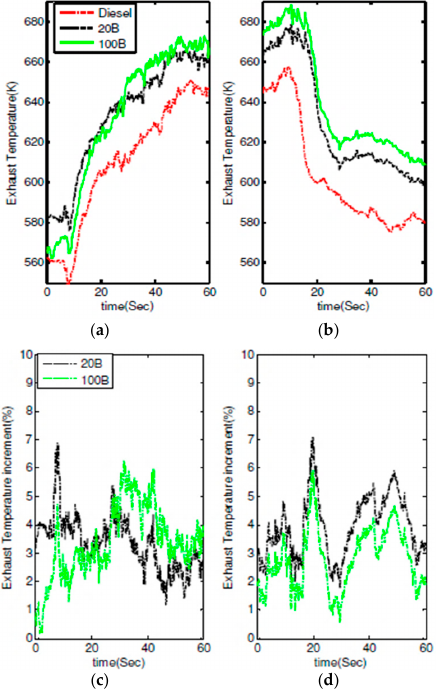
Figure 6. Time response of exhaust temperature for CI with biodiesel during ( a ) positive (210–420 Nm) and ( b ) negative torque transition at 1500 rpm. Corresponding temperature percentage change at ( c ) positive and ( d ) negative torque transition.